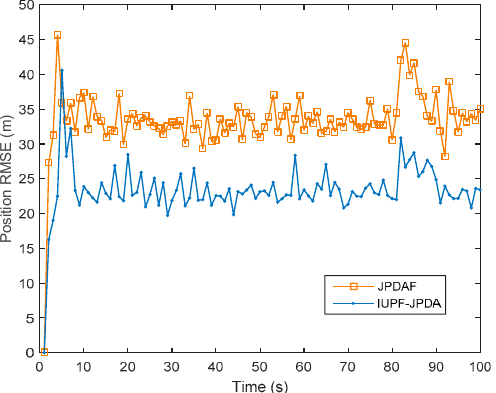
Figure 12. Comparison of position RMSE for target 2 in a multi-target simulation experiment.